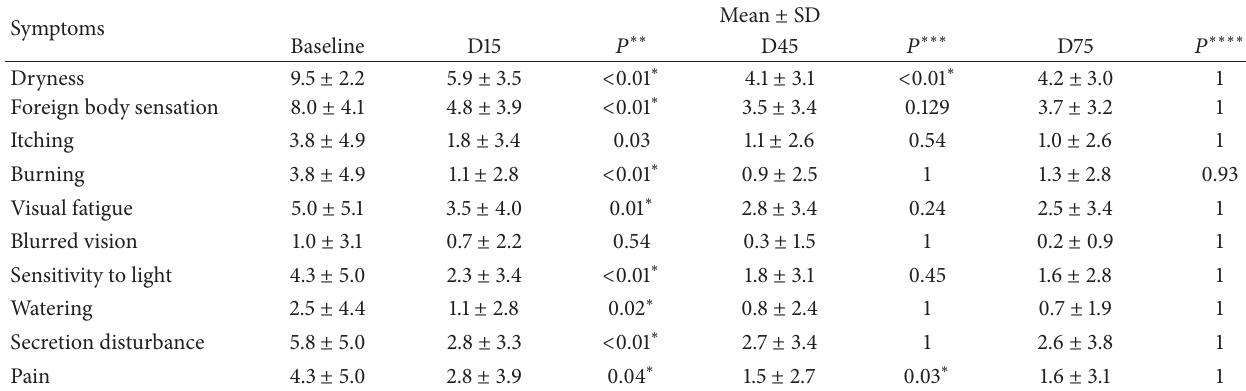
Table 1: 10 ocular surface symptoms’ evaluation during IPL treatments.